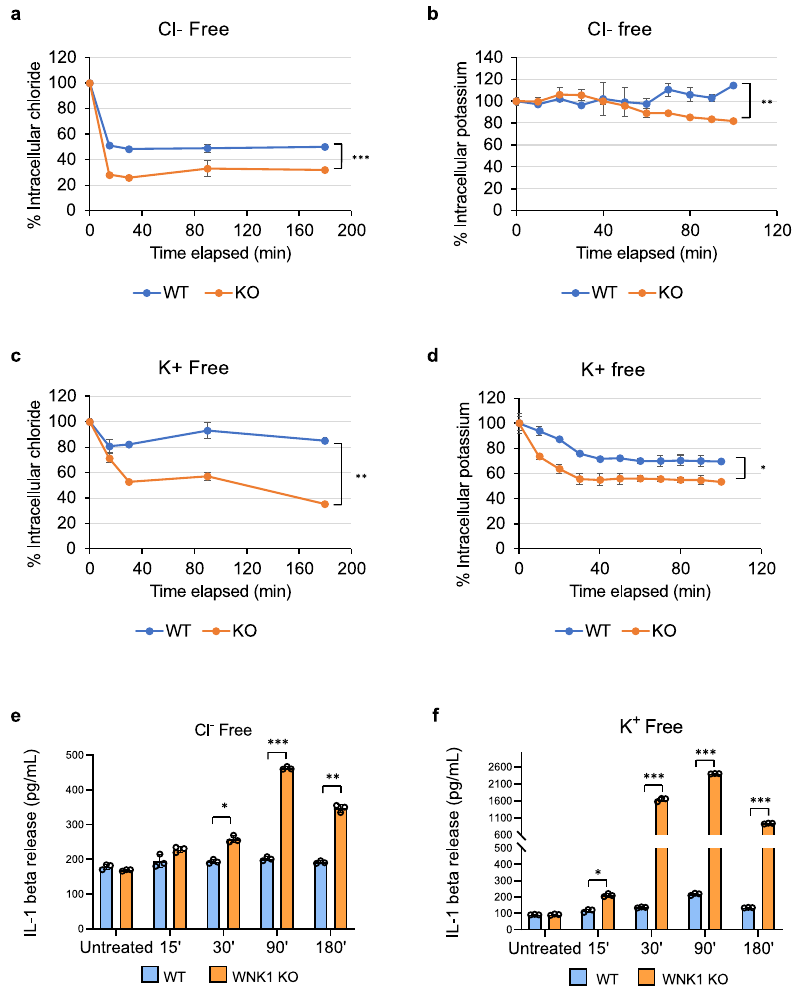
Fig. 7 Potassium and Cl − ef fl uxes drives NLRP3 activation in WT and WNK-KO cells. a , c Quanti fi cation of intracellular Cl − of LPS-primed (4 h) primary Wnk1 + / + LysMCre + (WNK1 WT) and Wnk1 fl ox/ fl ox LysMCre + (WNK1 KO) BMDMs in Cl − free ( a ) or K + free ( b ) media. Quanti fi cation of intracellular K